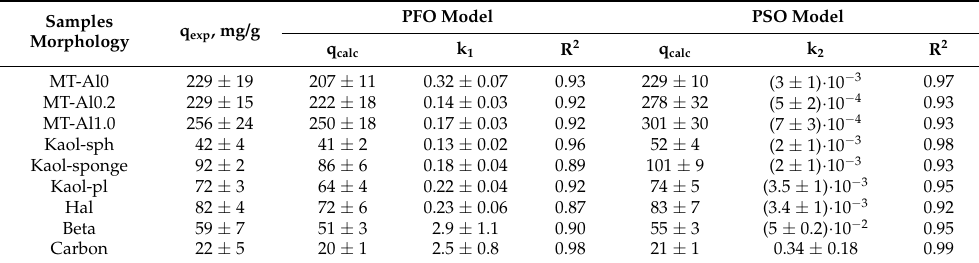
Table 3. Parameters of the kinetic models of sorption of albumin on aluminosilicates with different